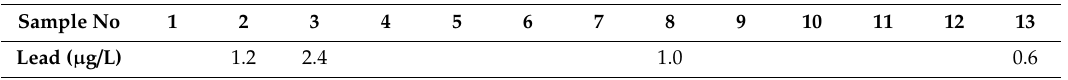
Table 3. Lead concentrations ( µ g / L) in 13 tap water samples collected from residences located in the neighborhood of Manchester, Houston,